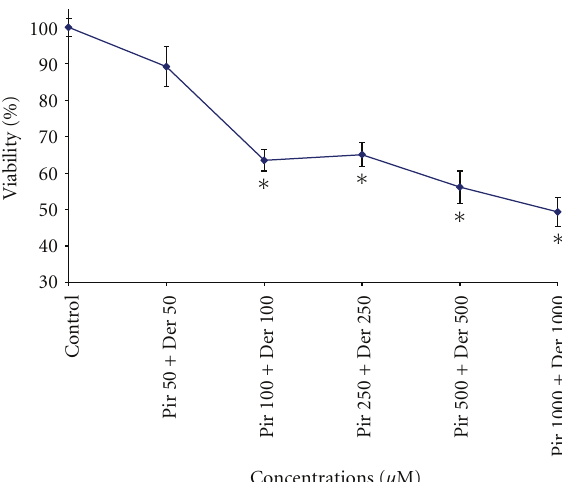
Figure 2: Antiproliferative e ff ects of coadministration of piroxicam (Pir) and deracoxib (Der) on canine mammary carcinoma cell line after 72h incubation. Data are expressed as the percentage of inhibition compared with control in which cell survival was assumed as 100%. ∗ P < 0 . 05 ( n =